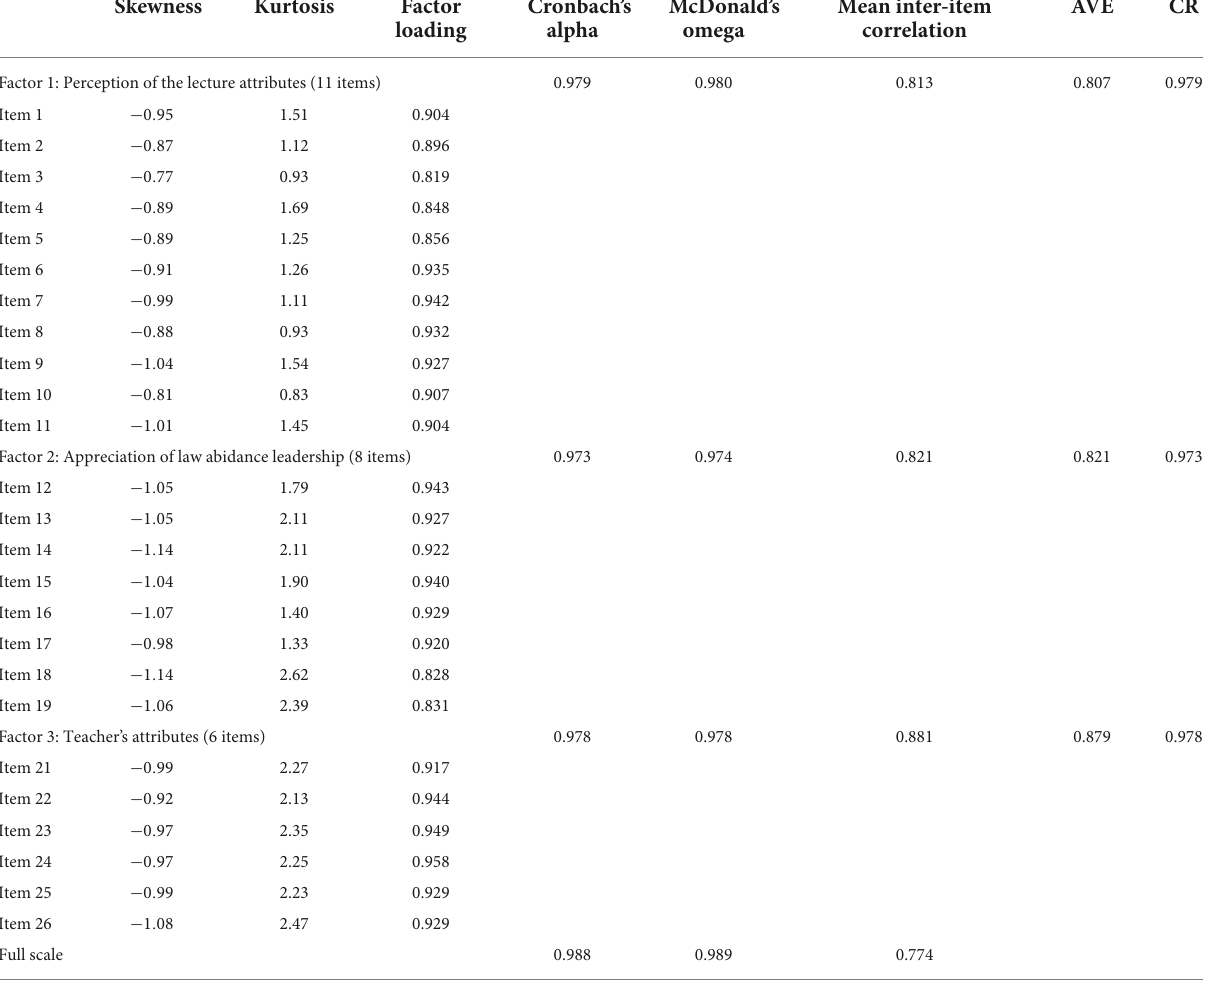
TABLE 2 Reliability and validity of full scale and factors of the